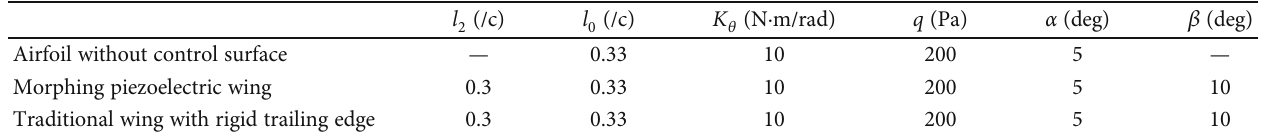
Table 2: Properties of di ff erent airfoils.